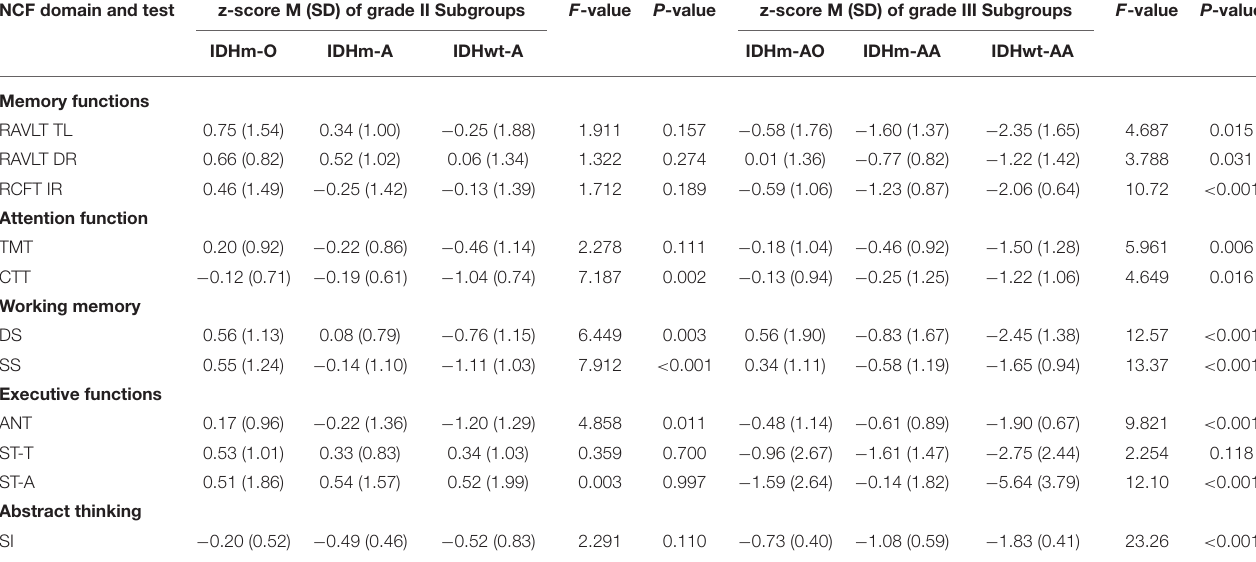
TABLE 5 | Differences of neurocognitive performances (z-scores) in subgroups based on molecule. NCF domain and